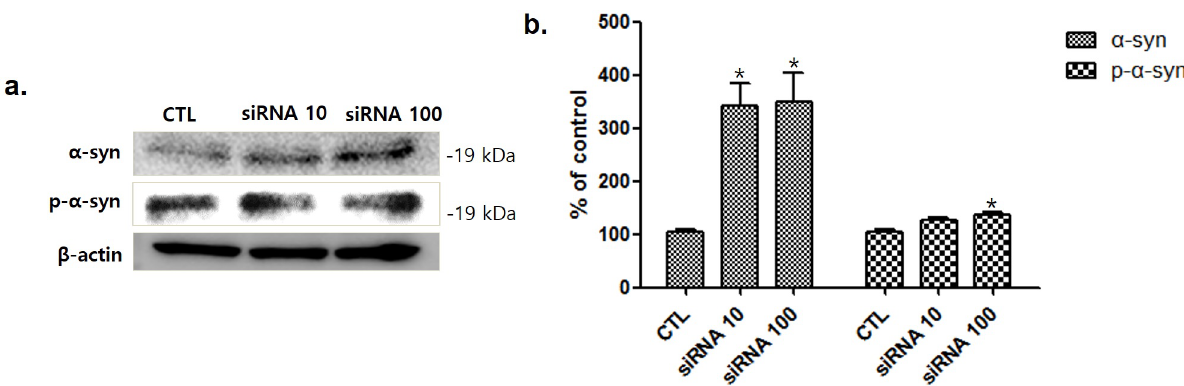
Figure 7. Western blot analysis of α -synuclein ( α -syn) and phosphorylated- α -syn (p- α -syn) after treatment of C2C12 cells with serine/arginine-rich protein specific kinase 3 ( srpk3 ) siRNA. ( a ) Western blot assay of α -syn and p- α -syn, after srpk3 siRNA application. ( b ) Quantified protein levels of the Western blot results ( n = 3). Control (CTL), negative control siRNA treatment (100 nM for 2 days); siRNA 10, srpk3 siRNA treatment (10 nM for 2 days); siRNA 100, srpk3 siRNA treatment (100 nM for 2 days). (* p < 0.05 was compared to control).